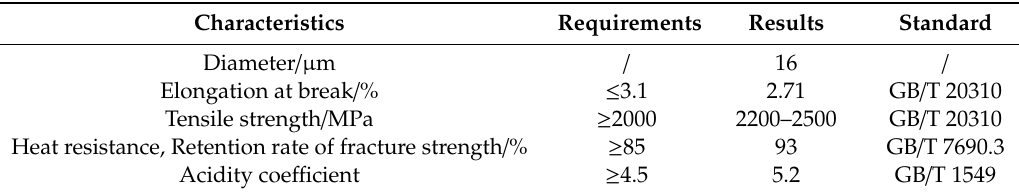
Table 2. Properties of the basalt